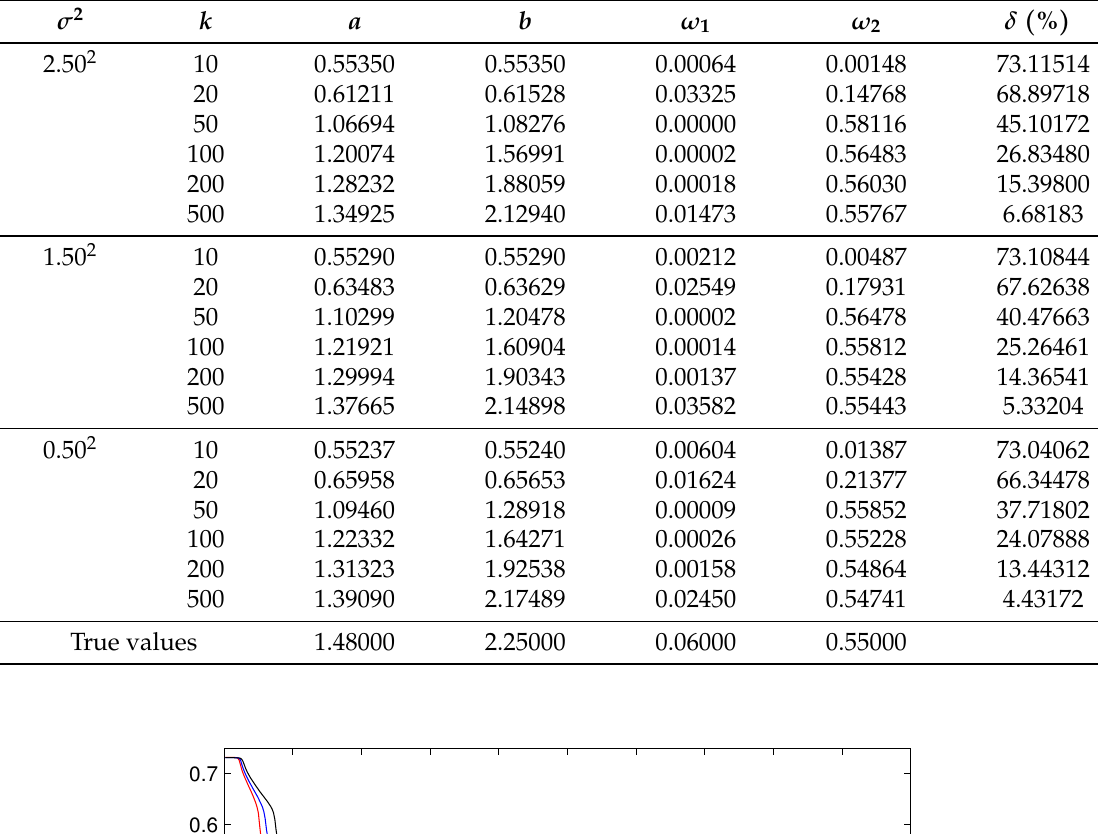
Table 1. The GI parameter estimates and errors.